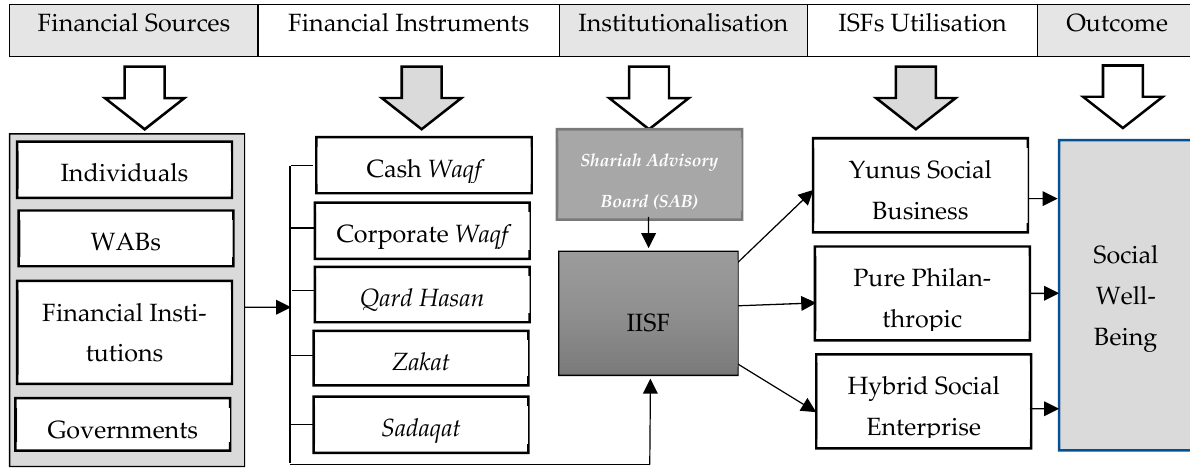
Figure 1. Institutionalisation of Islamic social funds.